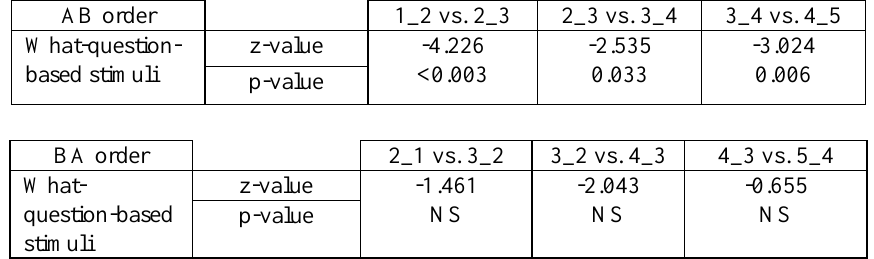
Table VIII. z- and p-values of three Wilcoxon matched pairs signed rank tests for each order of presentation comparing the “different” response rate between adjacent pairs for what-question-based